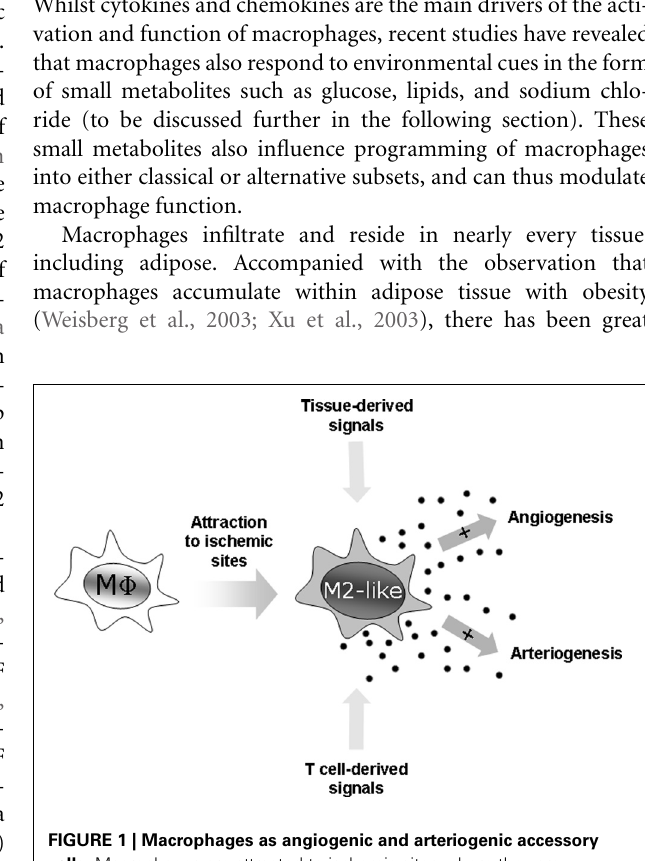
FIGURE 1 | Macrophages as angiogenic and arteriogenic accessory cells. Macrophages are attracted to ischemic sites where they are transformed into potent angiogenic and arteriogenic accessory cells by tissue- and T cell-derived